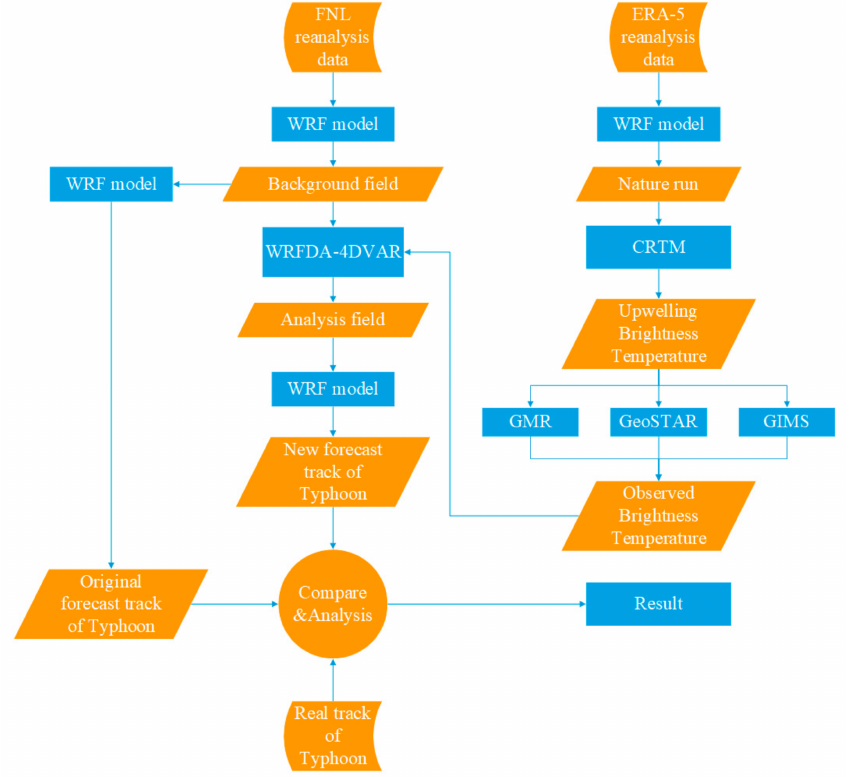
Figure 1. Geostationary orbit microwave observation system simulation experimental